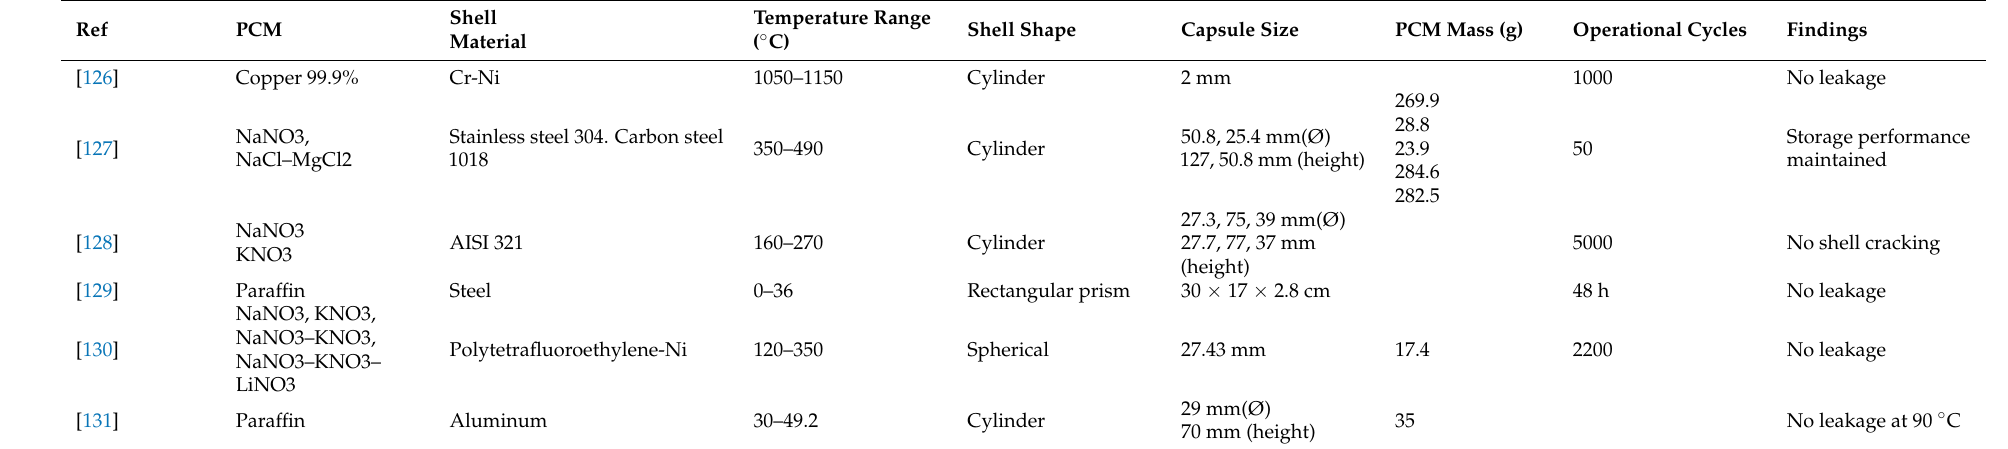
Table 3. PCM Macroencapsulation systems: materials and capsule